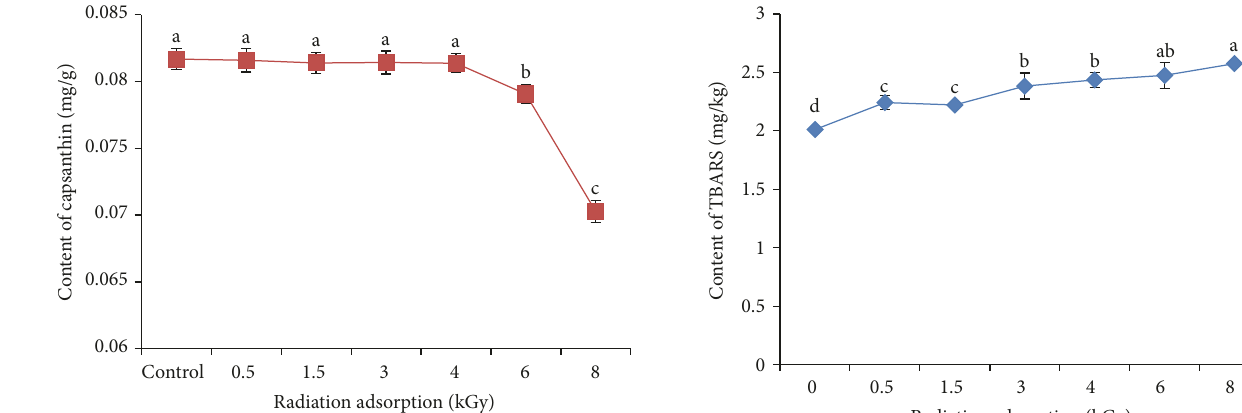
Figure 6: Effect of irradiation on lipid oxidation of SBJ. Values are represented as mean ± SD. Significance was tested by Duncan Multiple Range Test at 𝑃 < 0.05 , and values with the same superscript were found not significantly different from each